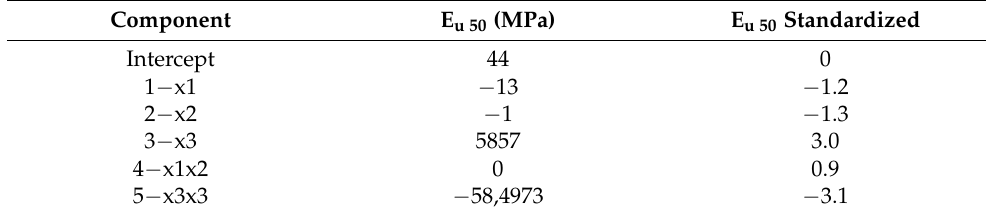
Table 8. Regression coefficients for the E u 50 model.